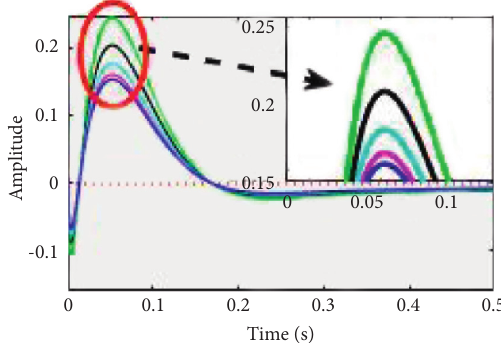
Figure 9: Unit step response curve cluster I of e